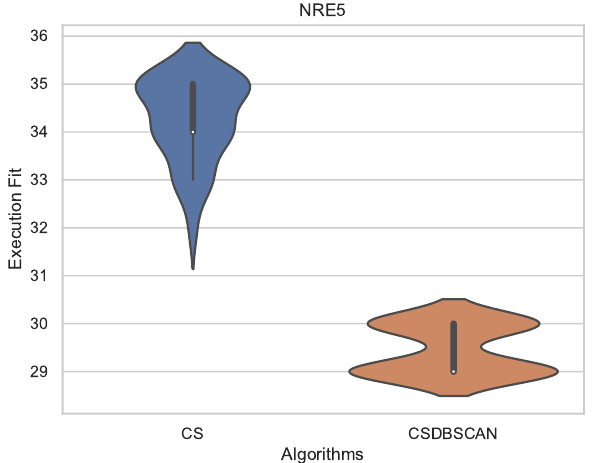
Figure 11. Instance NRE.5